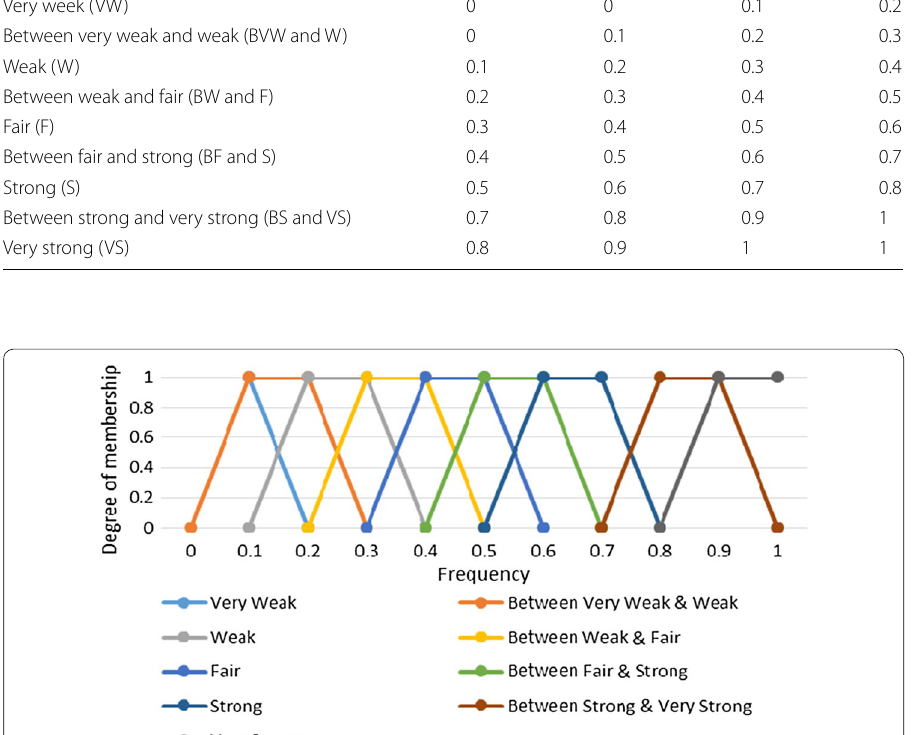
Fig. 3 Membership functions for linguistic values of